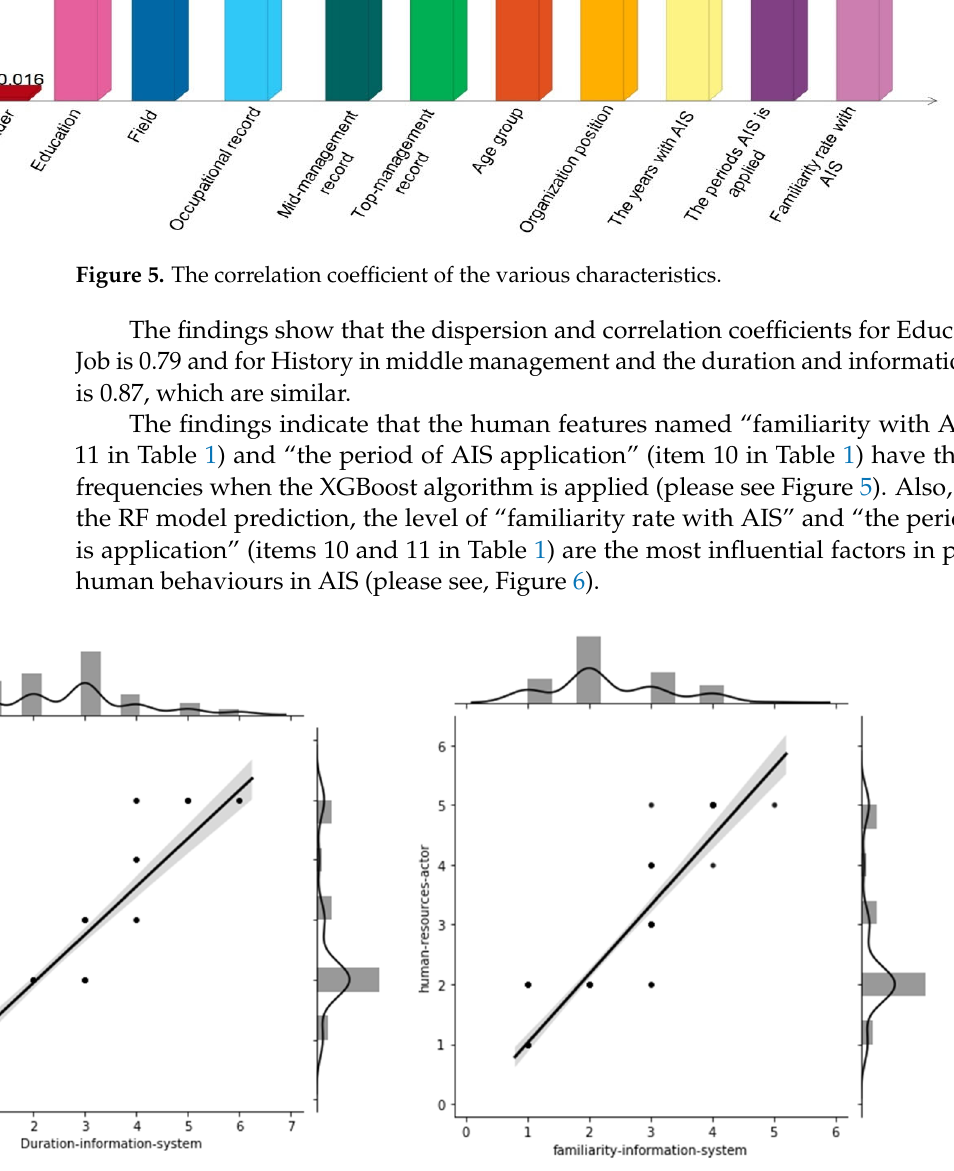
Figure 4. The Graph curvatures of various evaluated features vs. human actors.